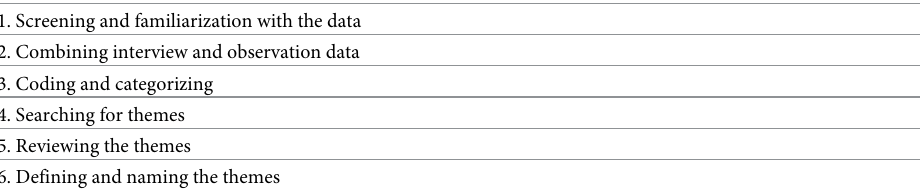
Table 2. Procedures of thematic